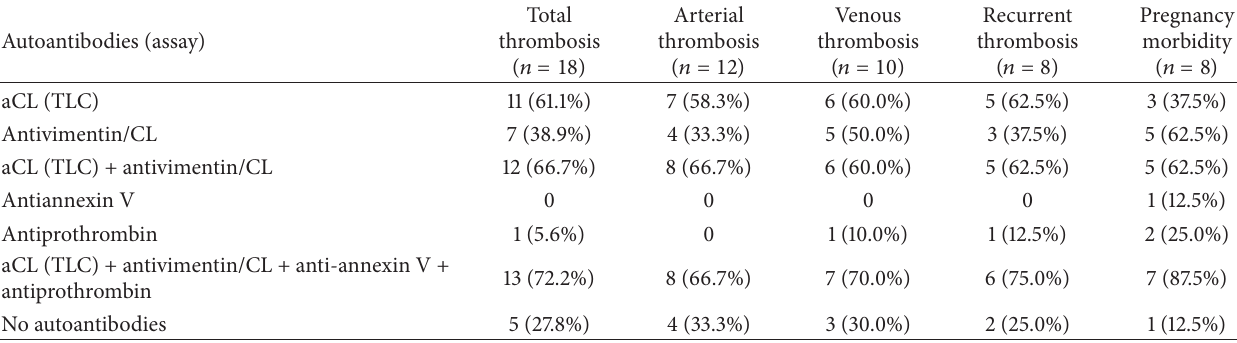
Table 4: Autoantibody prevalence in seronegative antiphospholipid syndrome (SN-APS) patients ( 𝑛 = 24 ) according to the clinical